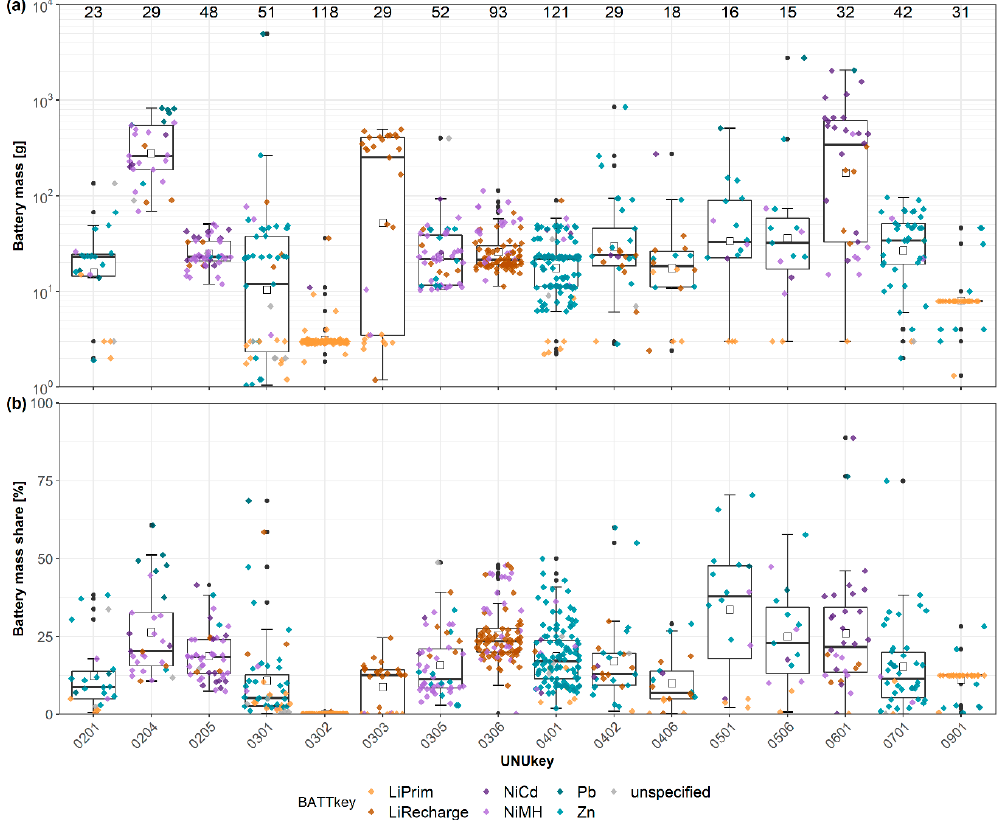
Figure 5. Mass ( a ) and mass share ( b ) of batteries remaining in WEEE classified as UNUkeys and distinguished by their chemical system (BATTkey). The number of observations (n) is displayed on top of the graph (a). The lower and upper hinges of the boxplots correspond to the first and third quartiles (the 25th and 75th percentiles). The median is drawn as a bold horizontal line; the mean is shown as a square. Upper/lower whisker is the largest/smallest observation less/greater than or equal to upper/lower hinge +/ − 1.5 ∗ IQR. The data of this figure can be found in the Supplementary